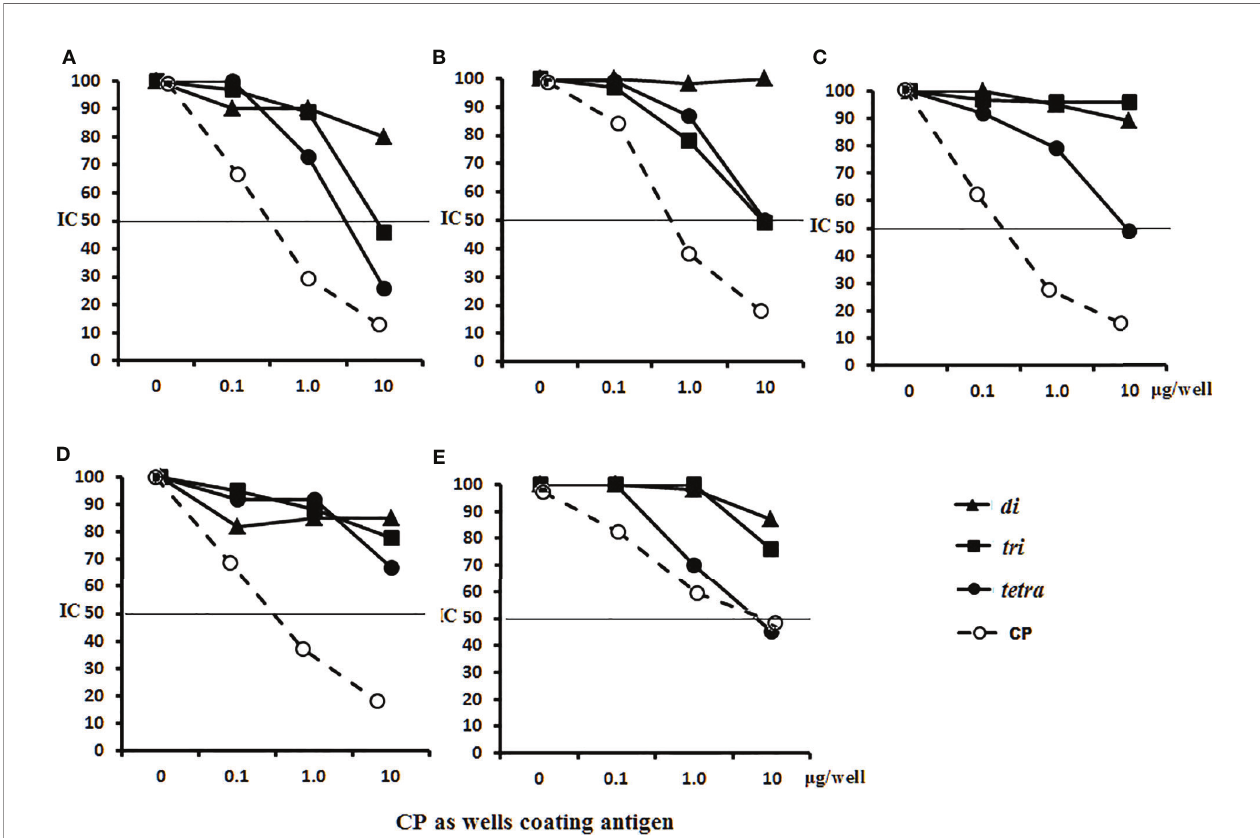
FIGURE 9 | Inhibition of IgG1 antibodies (Abs) recognizing CP of S. pneumoniae type 3 as a coating antigen with OS ligands and CP in immune sera. The horizontal line indicates IC 50 at the point of intersection of the inhibition curves. (A) Inhibition of IgG1 Abs in di – BSA conjugate sera in 1:400 dilution. (B) Inhibition of IgG1 Abs in tri – BSA conjugate sera in 1:800 dilution. (C) Inhibition of IgG1 Abs in tetra – BSA conjugate sera in 1:3,000 dilution. (D) Inhibition of IgG1 Abs in the pooled sera of BALB/c mice (n = 6) immunized with Prevnar 13 and Streptococcus pneumoniae type 3 CP at 1:400 dilution. (E) Inhibition of IgG Abs in the pooled sera of rabbits (n = 2) immunized with inactive S. pneumoniae type 3 cells at 1:2,500 dilution, three assays per antiserum. Different antisera dilutions were used to reach approximately equal antibody level in tested sera samples. IC 50 — the half maximal inhibitory